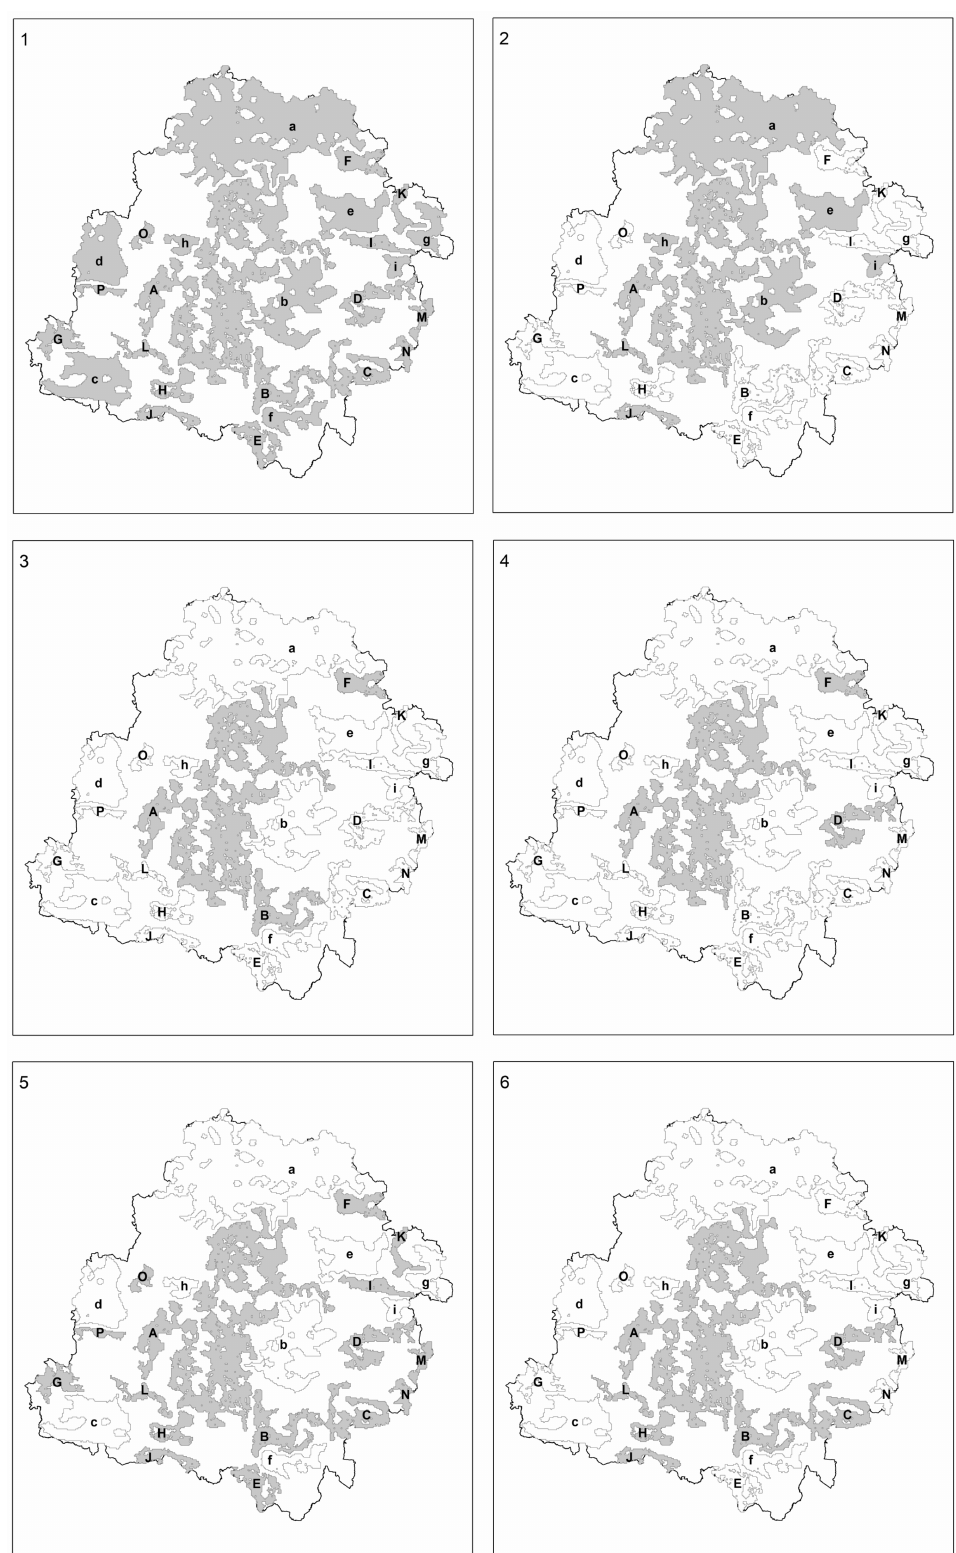
Figure 9. The occurrence of conditions of and contributing factors to the presence of identified land abandonment cold- and hotspots: 1—soil conditions; 2—landscape; 3—vicinity of roads and/or interchanges; 4—urbanization and suburbanization; 5—vicinity of forests; 6—surroundings of mineral exploitation